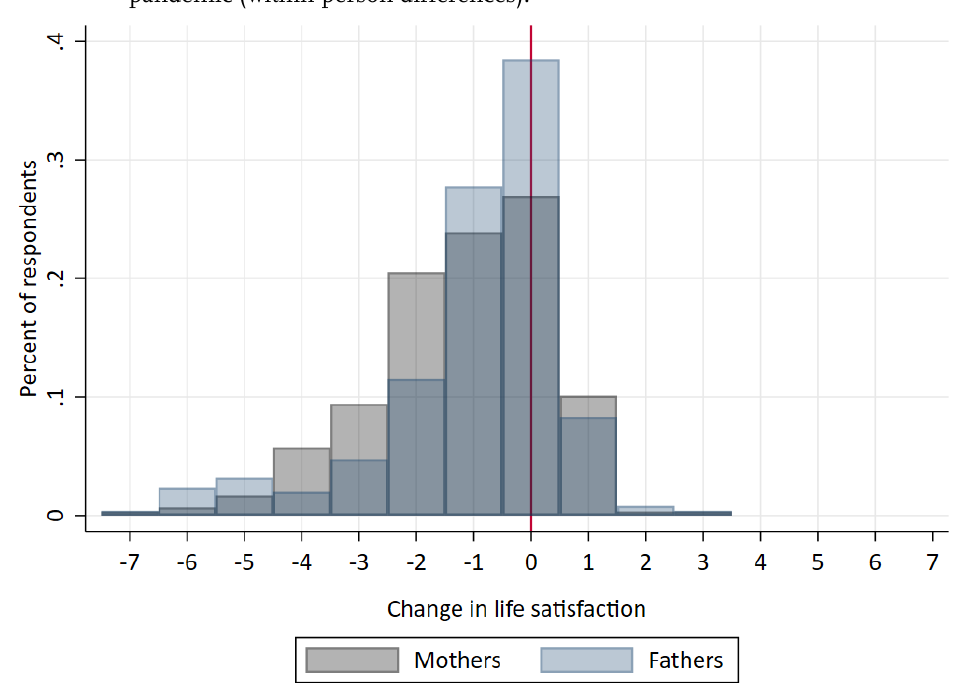
Figure 1 : Change in overall life satisfaction prior to and during the COVID-19 pandemic (within-person